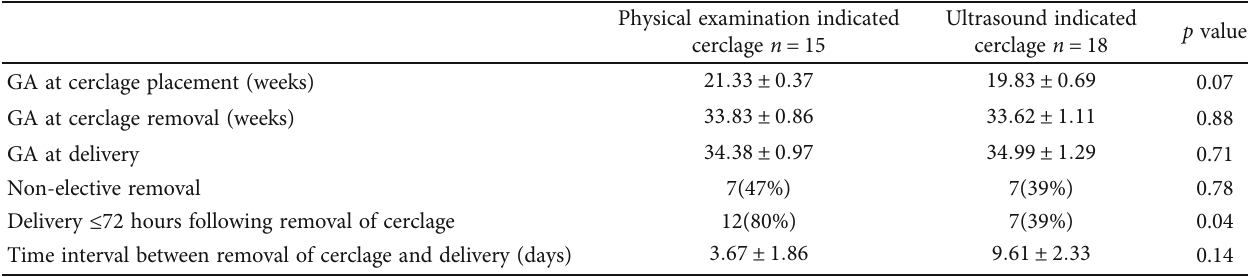
Table 2: Comparison of outcomes between women treated with physical examination-indicated cerclage versus ultrasound indicated cerclage.